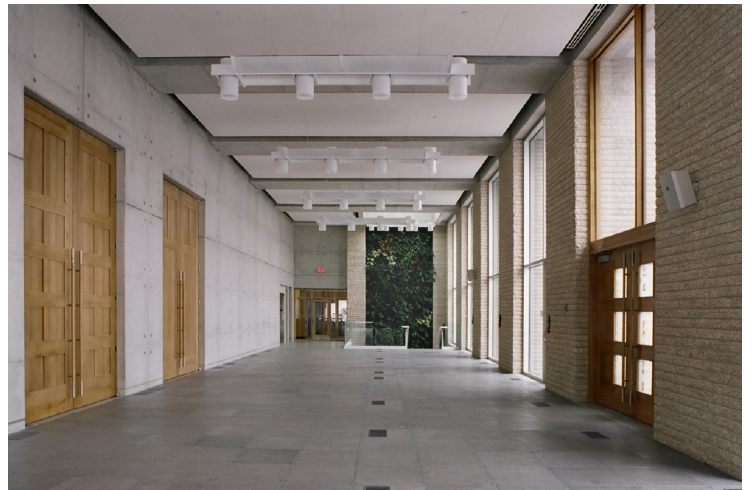
Figure 16. View of the narthex looking towards the “living wall” at the north end. (Credit: Steven Evans).